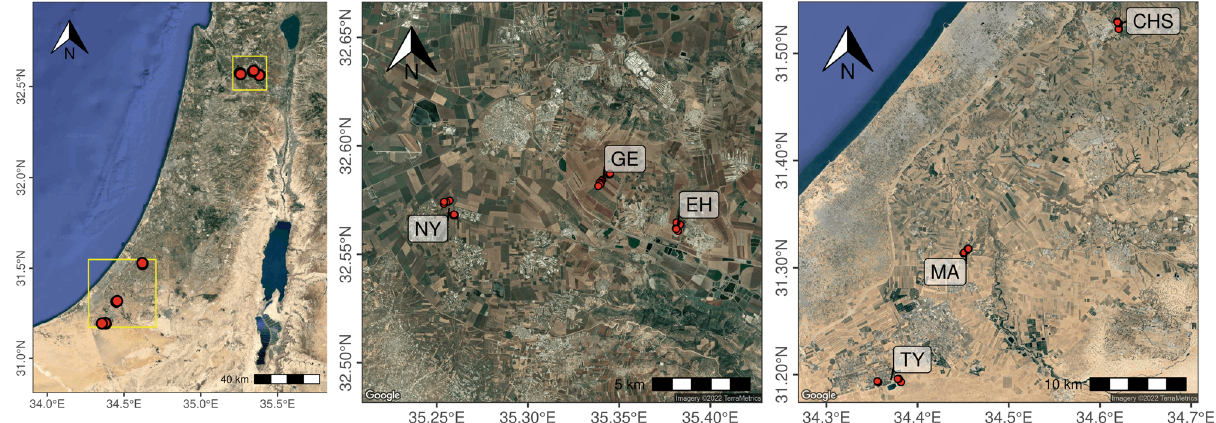
Figure 1. Maps of the study sites in Israel. The Yizrael valley has three sites Ein Harod (EH) Geva (GE) and Nir Yafe (NY); three sites Magen (MA), Chavat HaShikmim (CHS) and Talmey Yosef (TY) were located in the north-west part of the